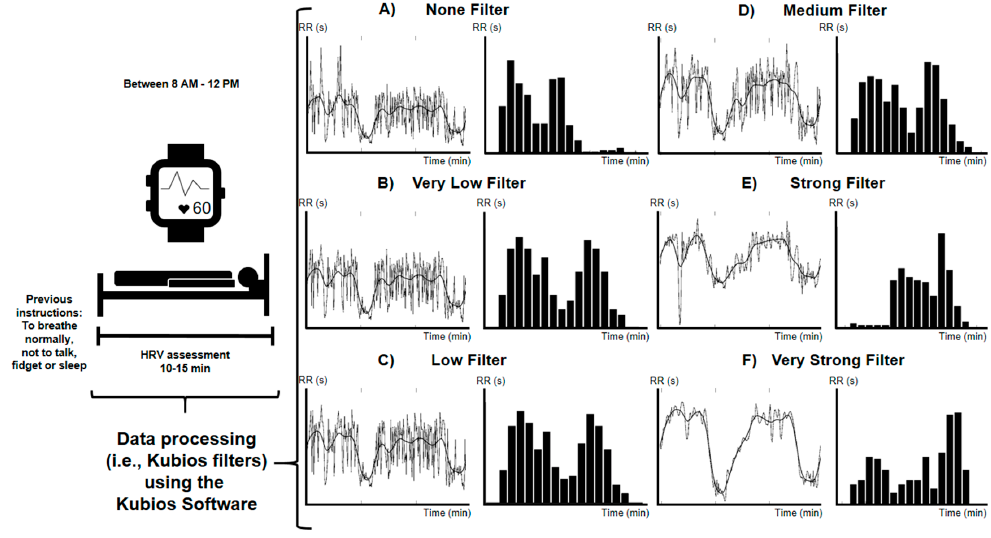
Figure 1. Study design. HRV: heart rate variability. None ( A ), Very Low ( B ), Low ( C ), Medium ( D